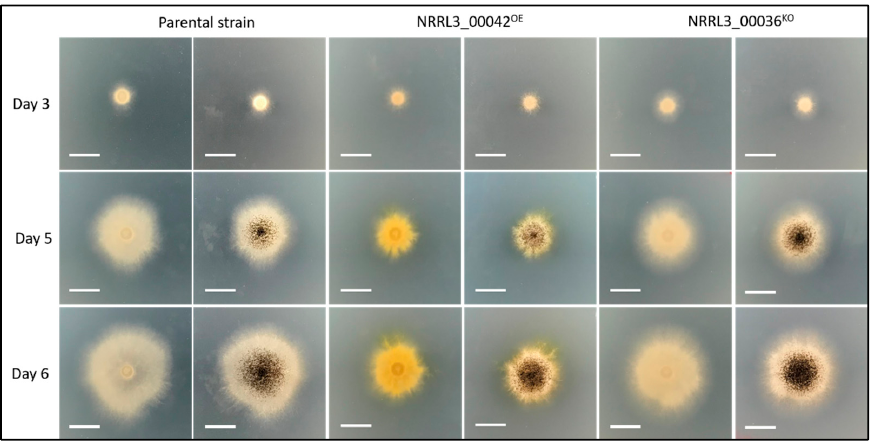
Figure 3. Growth profile of strains CSFG_7003 (parent), NRRL3_00042 OE and NRRL3_00042 OE _ ∆ NRRL3_00036 on agar plates containing minimum medium with 1% maltose. The scale bar represents 1 cm. Shown are images taken from the bottom (left) and the top (right) of the plates. The promoter of the glucoamylase is inducible by the presence of maltose. The